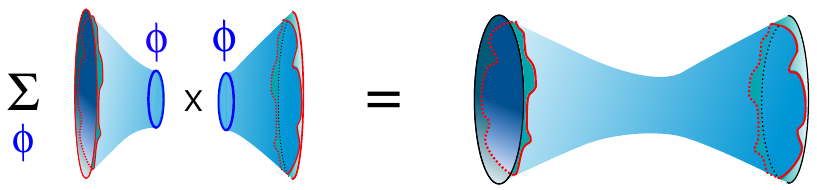
Figure 6 . Gluing together tubes by integrating over hyperbolic orbits with geodesic length 2 φ for a fixed spin